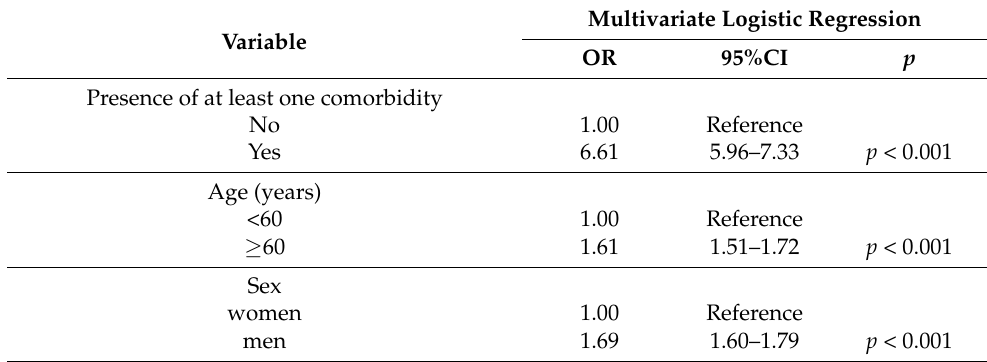
Table 5. The impact of comorbidities on risk of admission to the intensive care unit (ICU) controlled for the age and